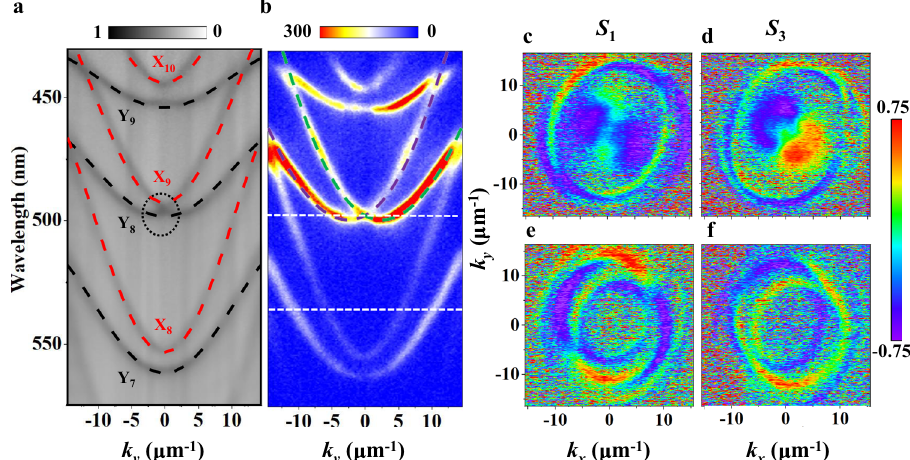
Fig. 2 | Re fl ection and PL measurements. a ARR and b ARPL of the microcavity withtheorganic-layerthicknessof990nm.Theunitsofthecolorbarsarearbitrary. The dotted curvesin a represent the simulated Xand Y cavitymodes, respectively. Thedashedcurvesin b ,indicatingthesplitCPmodes,arecalculatedbysolvingEq. (1) with the parameters E 0 = 2.495eV (497nm), m =2 : 2×10 (cid:2) 5 m e ( m e is the free